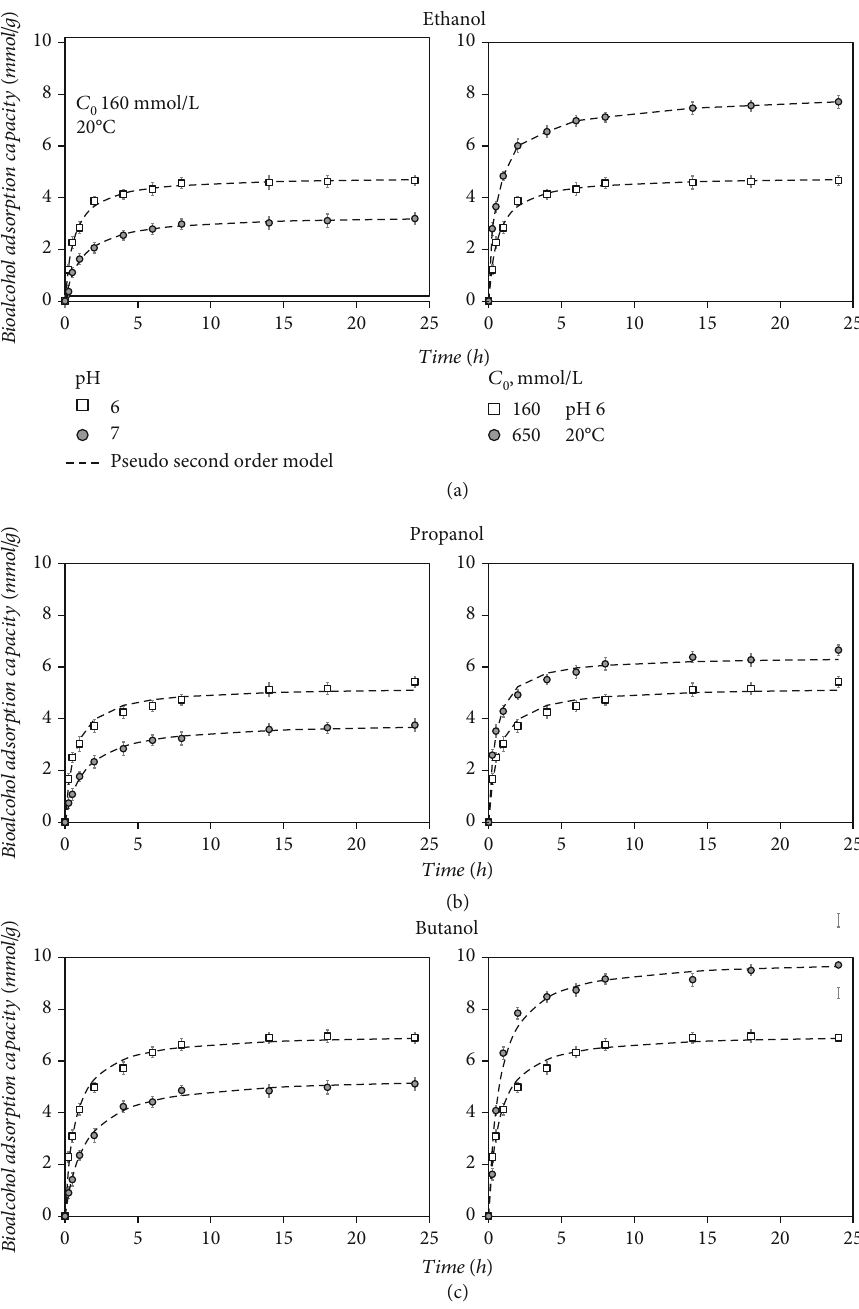
Figure 2: Adsorption kinetics of ethanol, propanol, and butanol from aqueous solutions with bone char as adsorbent at 20 °